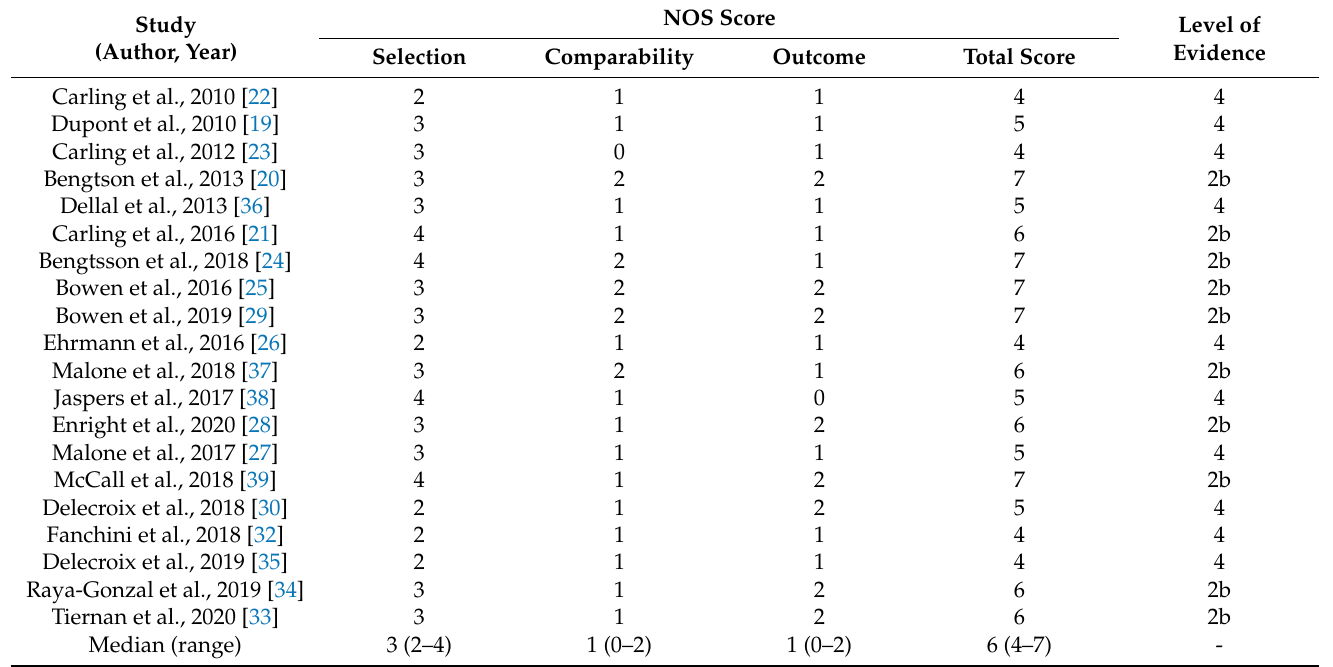
Figure 1. Flowchart of the search process and study selection. Table 1. Quality of included articles as assessed on the